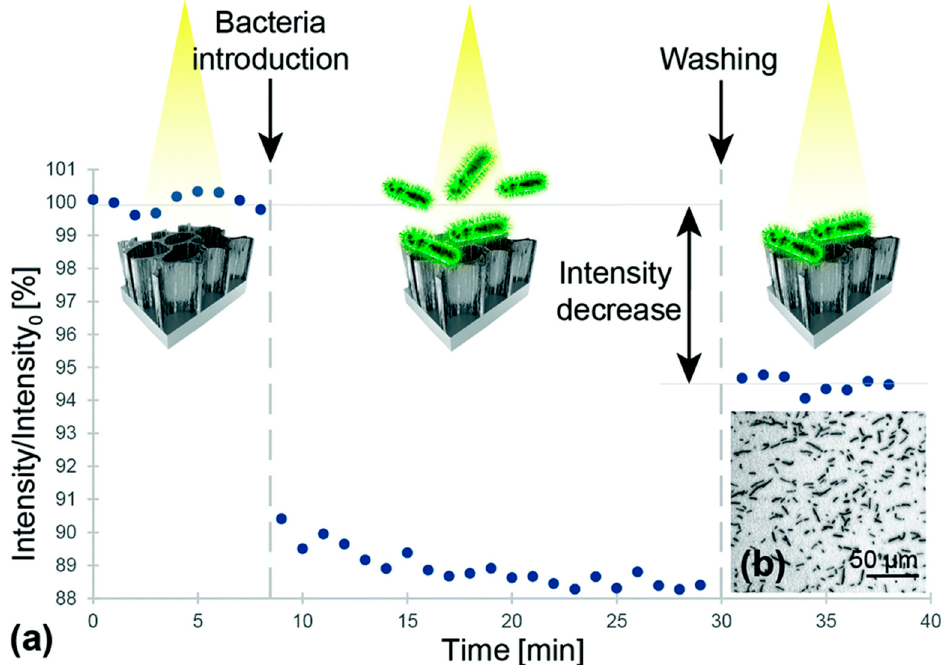
Figure 2. ( a ) Relative intensity change of the Hemag1P-modified PSiO 2 device upon exposure to L. acidophilus bacterial suspensions (10 7 cells per mL). ( b ) Microscope image taken after the biosensing experiment depicts L. acidophilus cells captured onto the aptamer-modified PSiO 2 device. Reproduced with permission from [56].